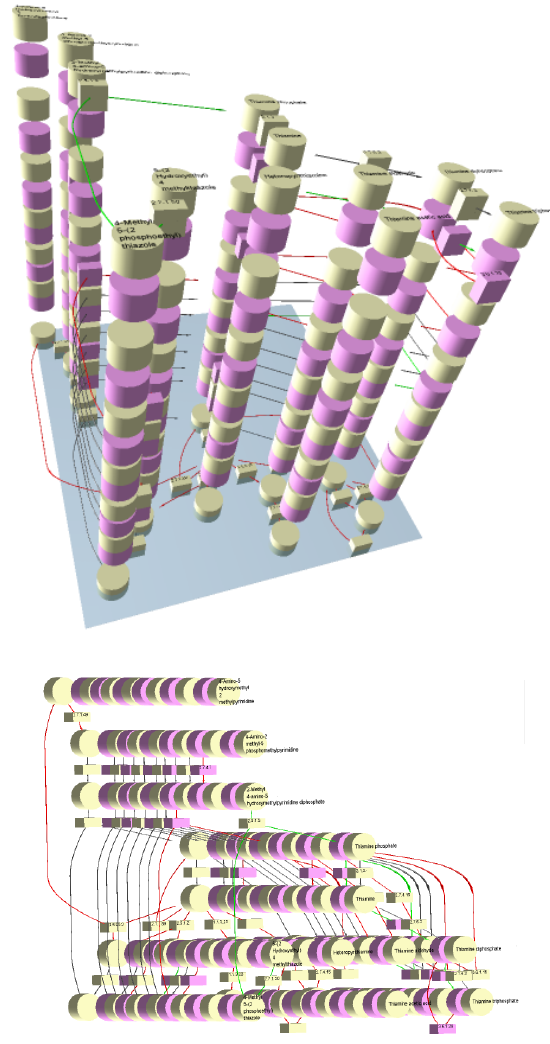
Fig. 8. WilmaScope screenshots for the Thiamine metabolism example. The top image is a perspective projection with the stratum representing the full metabolic pathway highlighted by the transparent blue plane. The lower image is a parallel projection which better shows the relative spacing between adjacent